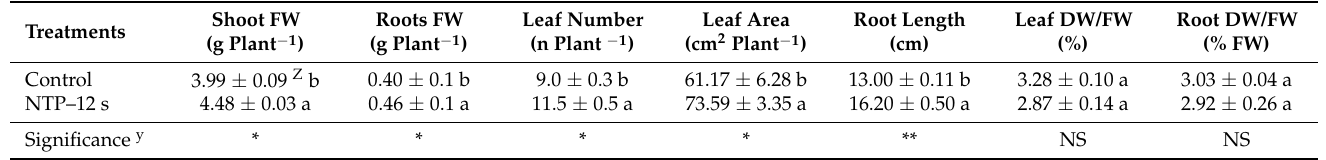
Table 2. Effect of NTP treatment (120 s every hour) of nutrient solution on leaf and root fresh weight (FW), leaf number and area, (FW), leaf number, leaf area, root length, and DW/FW percentage ratio in leaves and roots of baby leaf lettuce plants grown in an indoor hydroponic system for nine days (Experiment 4).